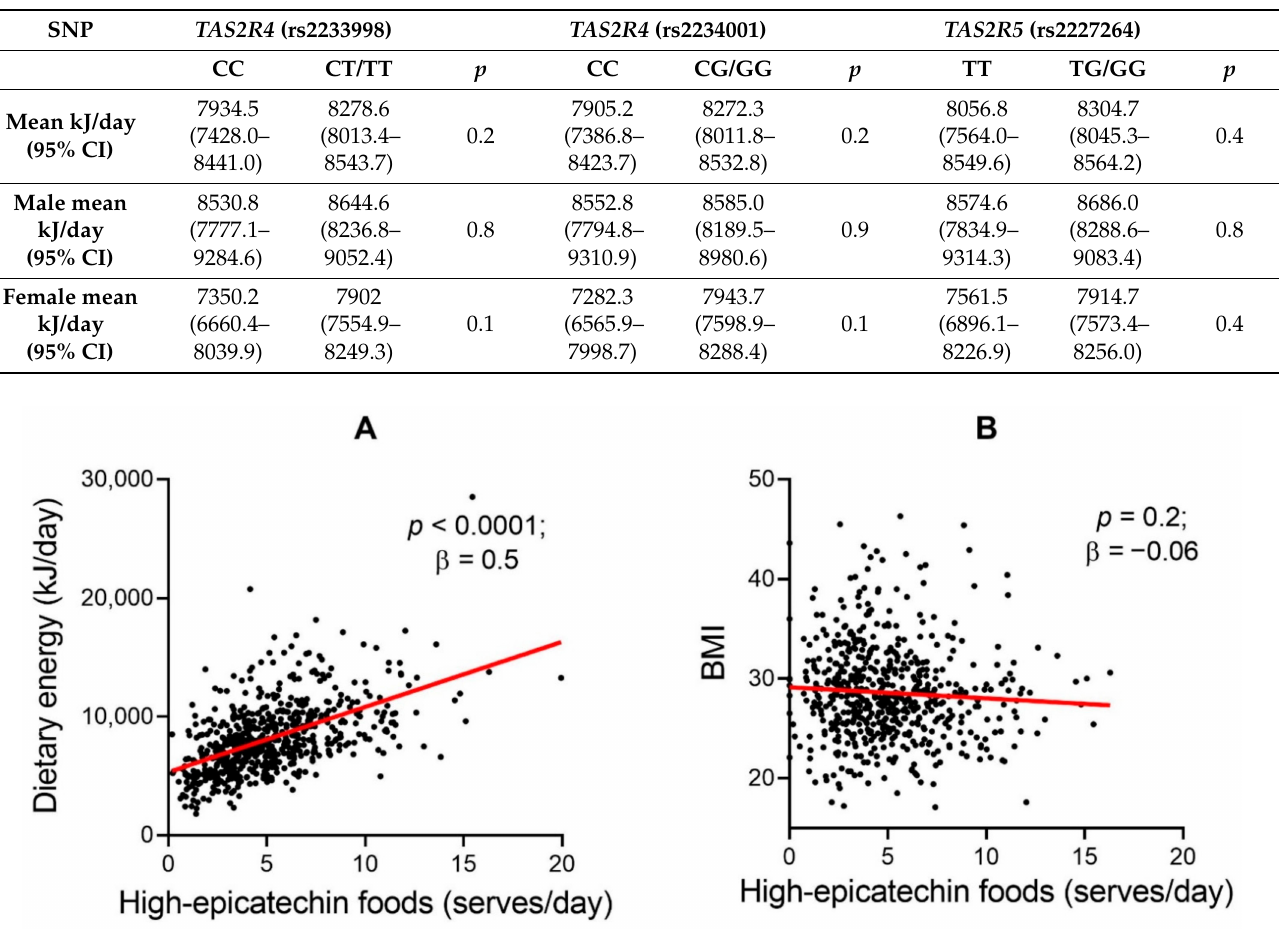
Table 4. Daily energy intake is not significantly associated with TAS2R genotype.